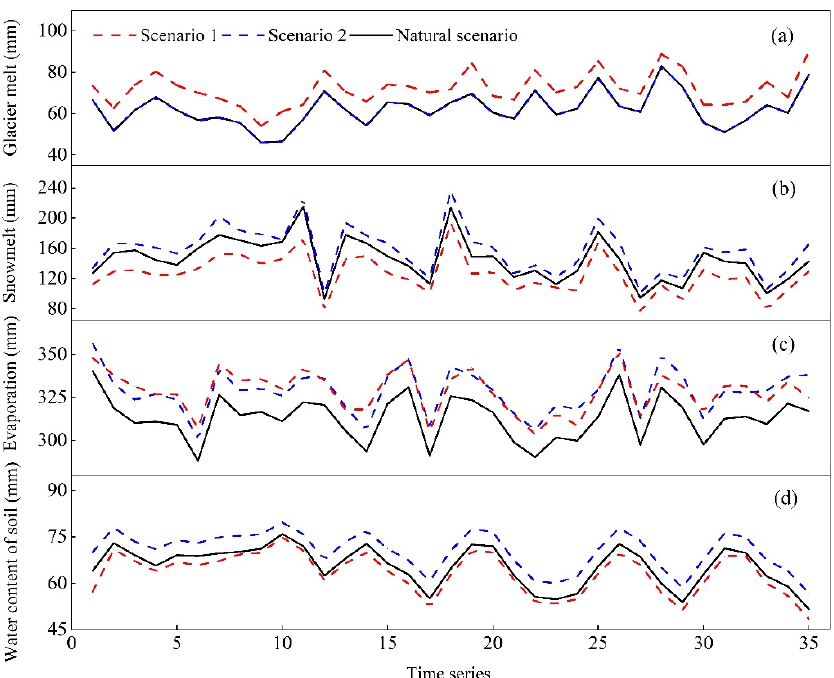
Figure 6. Responses of glacier melt ( a ), snowmelt ( b ), evaporation ( c ), and water content of soil ( d ) to different scenarios in Period 1.